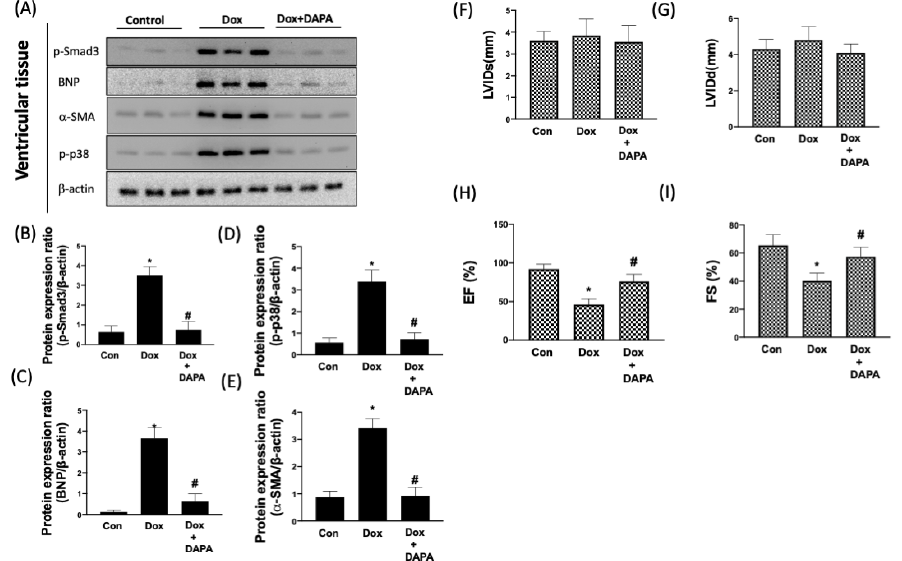
Figure 7. DAPA protects heart function in response to Dox treatment. Representative Western blot images ( A ) and densitometric analysis of phospho-Smad3 ( B ), BNP ( C ), α -SMA ( D ), and phospho-p38 ( E ) in control (CON) group, Dox only group, and combination treatment of Dox and DAPA (Dox + DAPA) group were shown. ( F ) Left ventricular internal dimension at end-diastole (LVIDd), ( G ) left ventricular internal dimension at end-systole (LVIDs), ( H ) ejection fraction (EF), and ( I) frac- tional shortening (FS) of the heart were measured using echocardiography. Results are shown as means ± SD of three independent experiments. Statistical analysis was performed using one-way ANOVA with a Bonferroni post hoc test. [* p < 0.05 compared to the control group; # p < 0.05 com- pared to the Dox-only group].